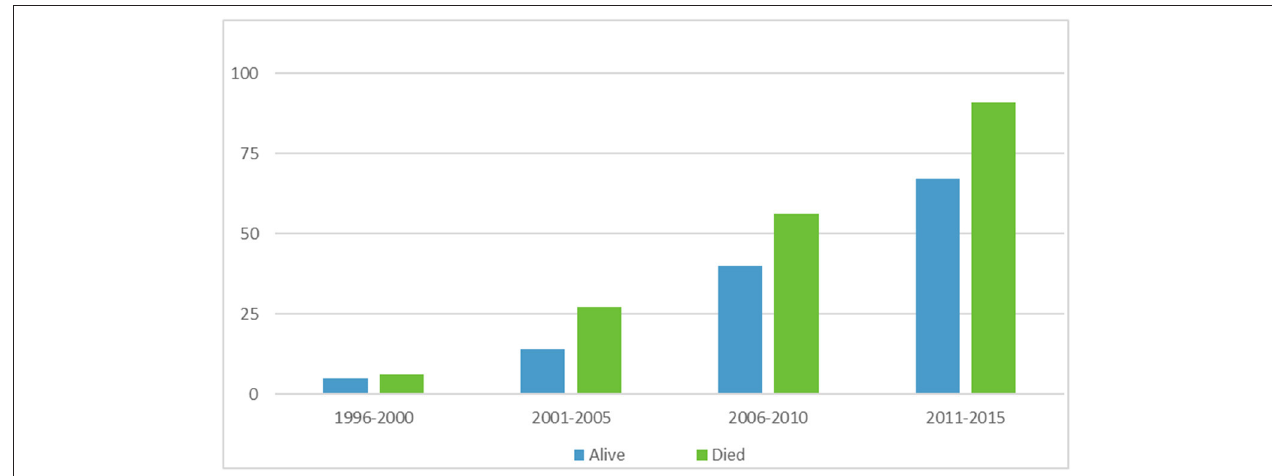
FIGURE 1 | ECMO utilization and survival in 5 year increments.